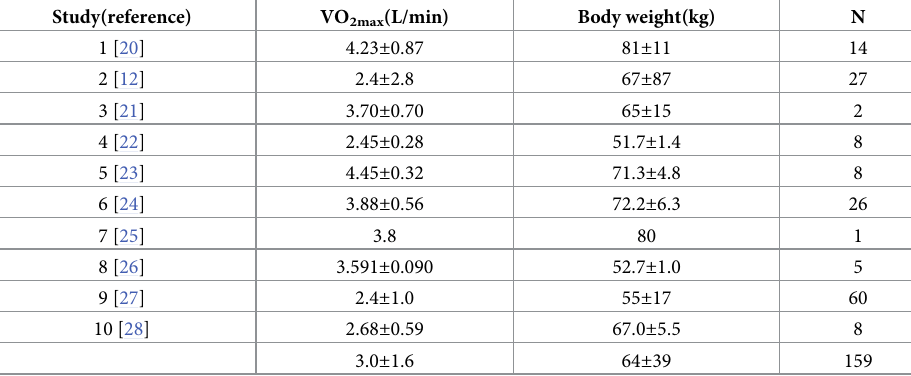
Table 1. Data on VO 2max and body